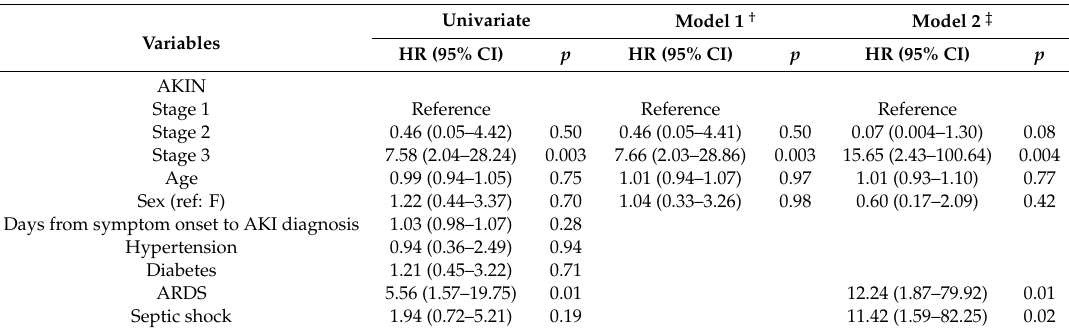
Table 5. E ff ect of AKI on mortality among AKI